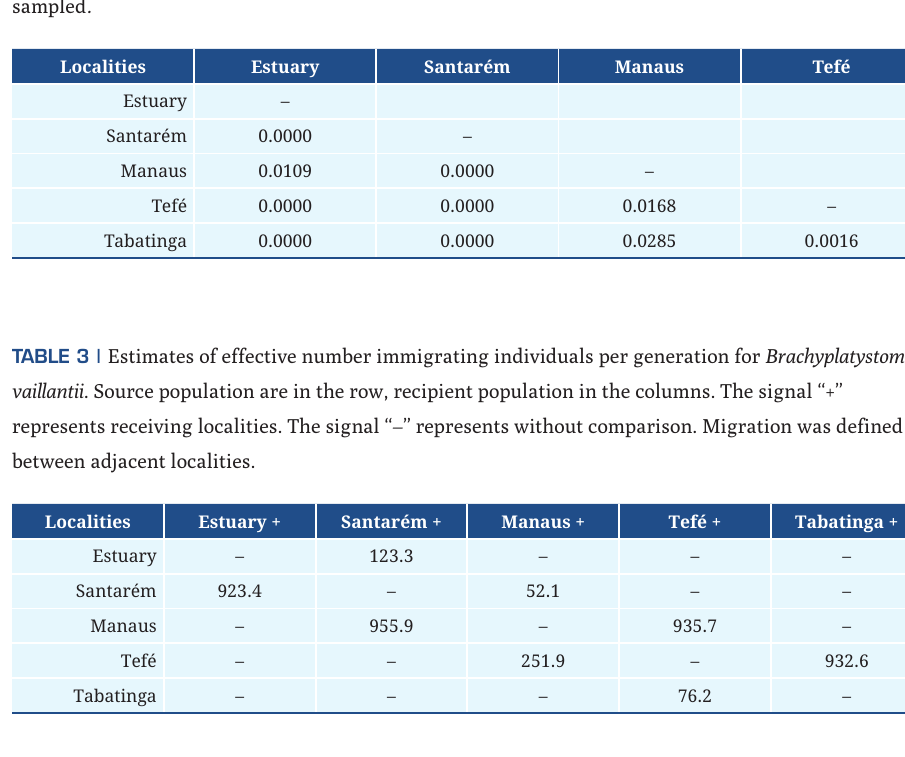
TABLE 2 | Pairwise F values between the Brachyplatystoma vaillantii individuals from the localities ST sampled .